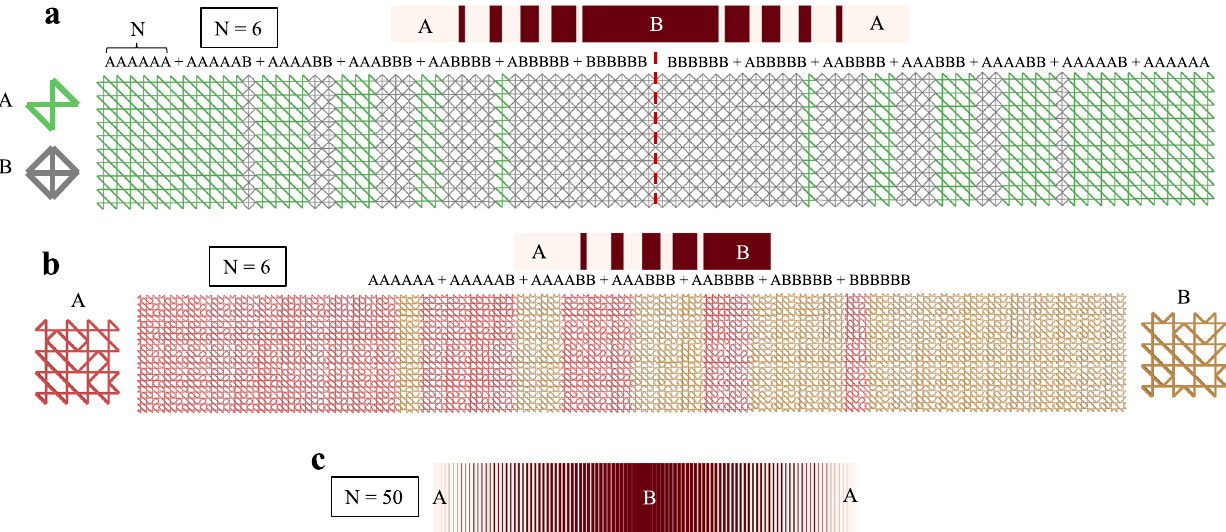
Fig. 5 Graded truss lattice materials using a building-block-based method. a Gradient of microstructures generated by symmetrically composing two elementary building blocks (from Fig. 1b) with N = 6 fi nite-length strings. The dashed red line represents the axis of symmetry. b Gradient of microstructures generated by composing two previously inverse-designed unit cells (from Fig. 2e) with N = 6 fi nite-length strings. A symmetric generation is not here shown for the sake of clarity in the visualization. c Example of gradient smoothness induced by increasing N to 50. A and B represent two different